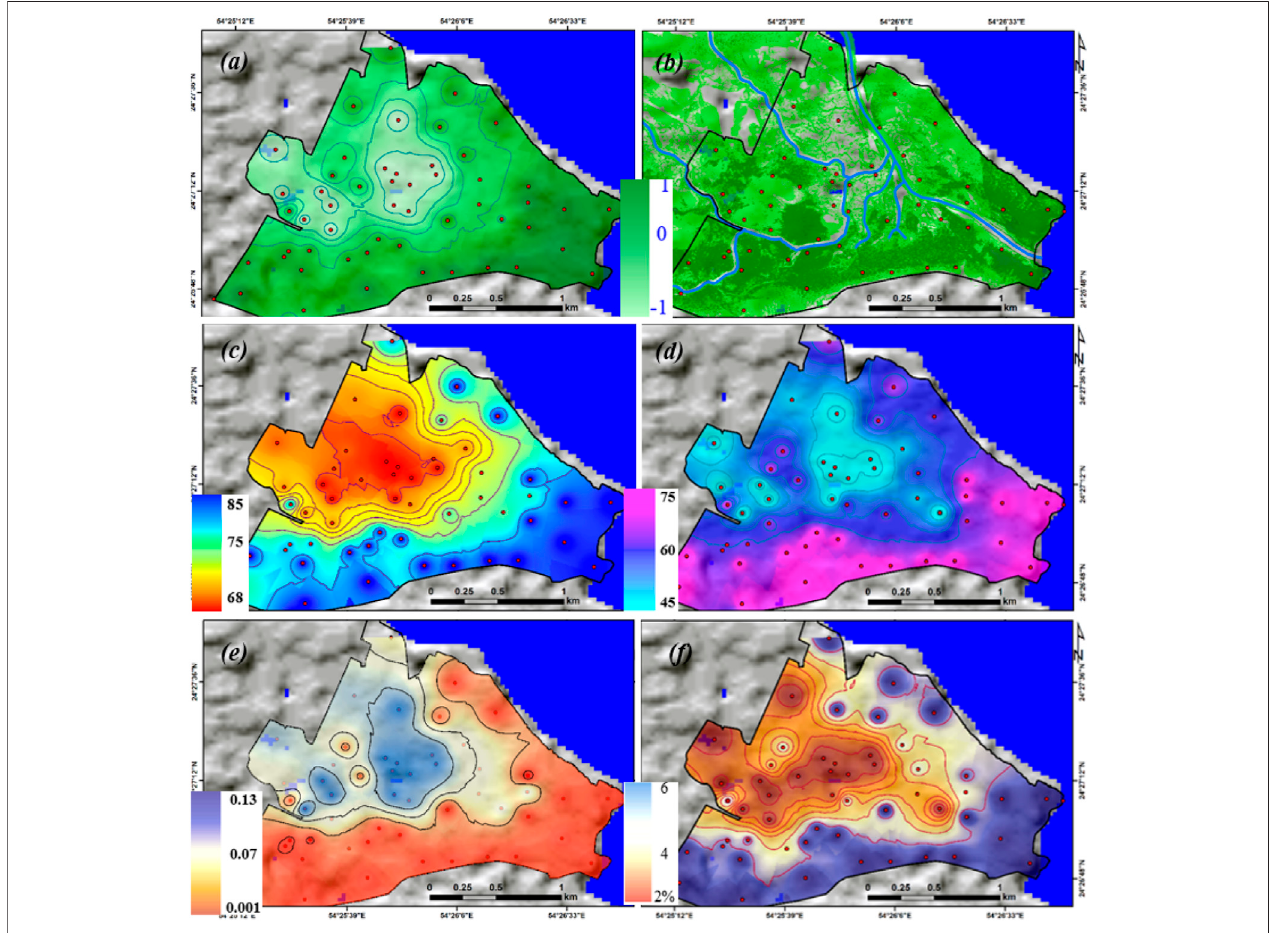
FIGURE 15 | Mangrove classes of the study site (A) , tidal channels in mangrove forest (B) , interpolated maps showing the spatial variation of CaCO 3 and salinity concentrations (C,D) , and nitrogen and organic matter content (%) in soil mangrove forests (E,F) , respectively.